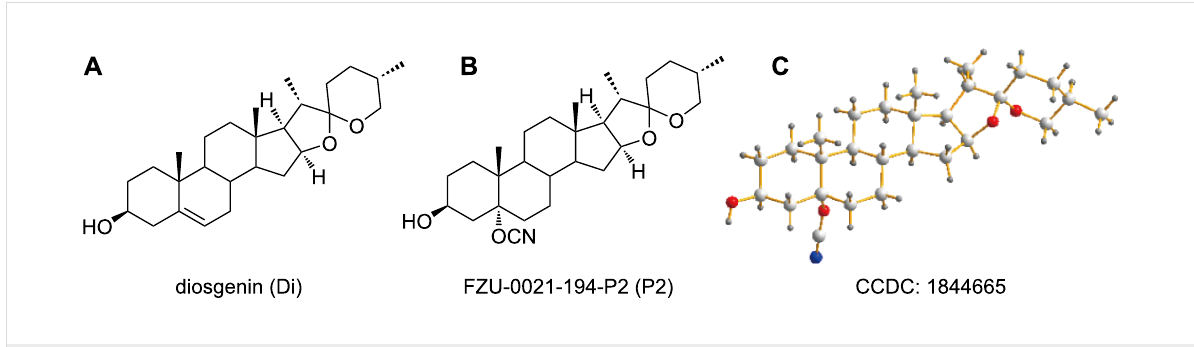
Figure 1: (A) The structure of diosgenin. (B) The structure of FZU-0021-194-P2. (C) X-ray crystallographic analysis of FZU-0021-194-P2. CCDC 1844665 contains the crystallographic data of P2. The data can be obtained free of charge from the Cambridge Crystallographic Data Center.